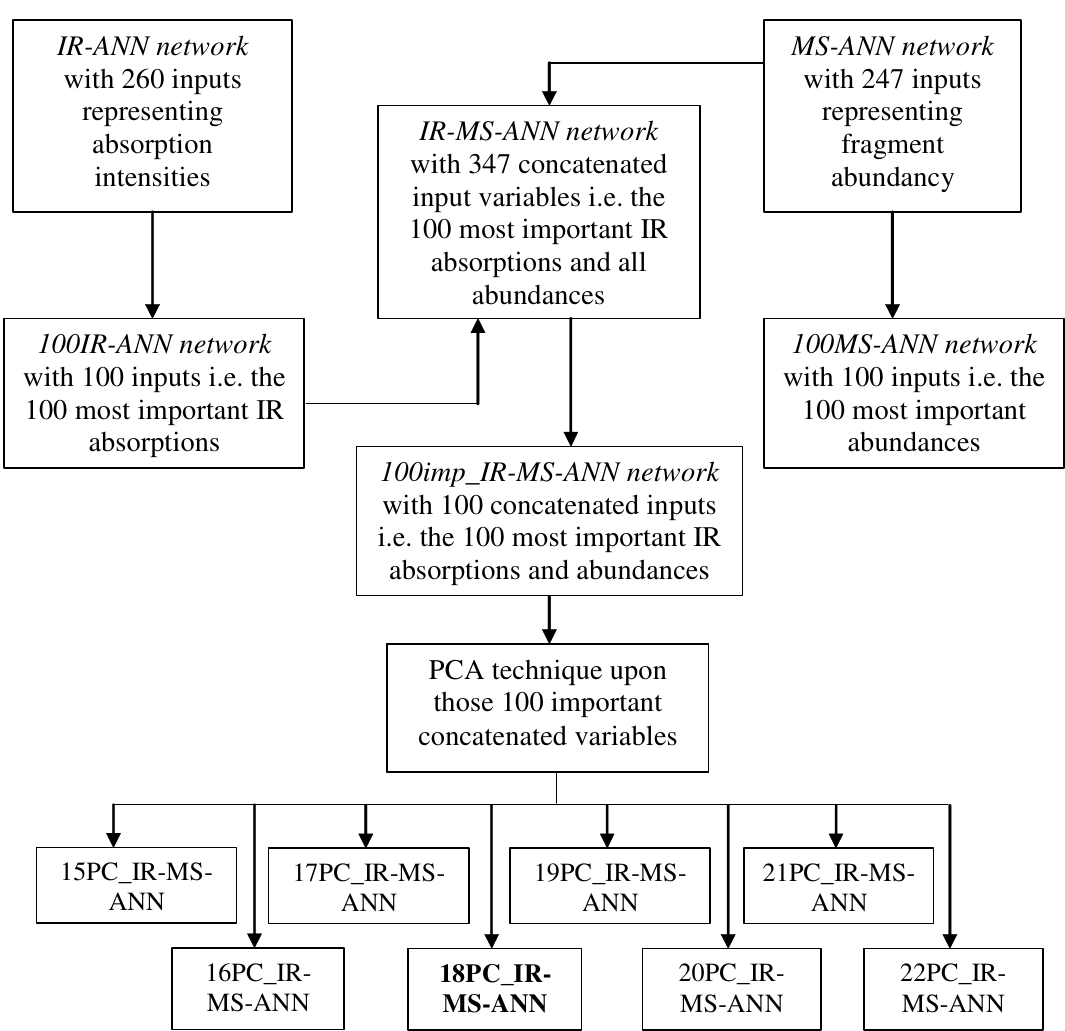
Figure 2. Steps performed in order to obtain the 100imp_IR-MS-ANN and then the PC-ANN